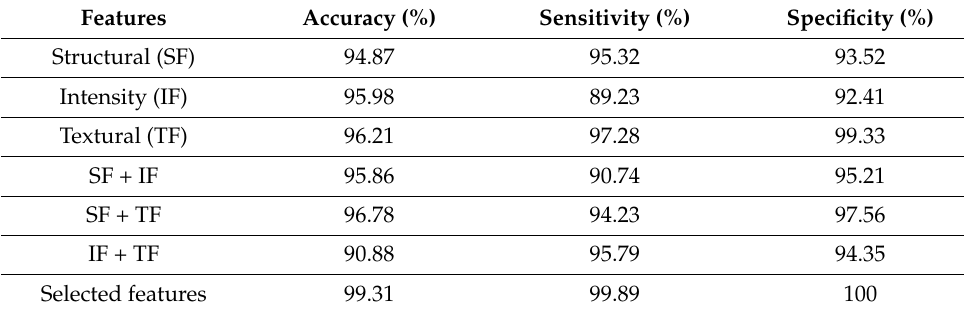
Table 7. Impact of features in detecting glaucoma from LAG dataset.